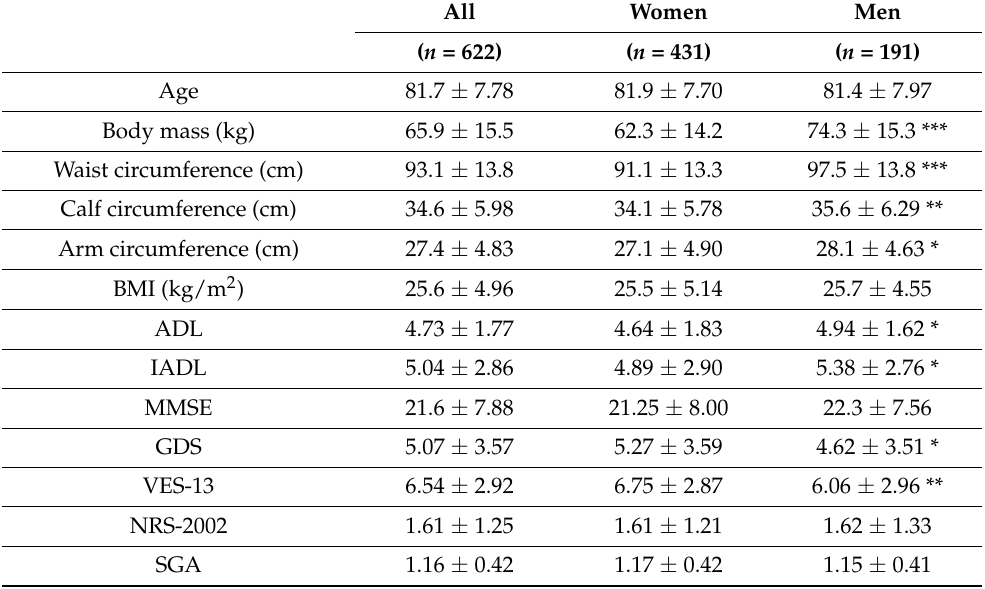
Table 1. Characteristics of the patients—summary statistics for age, anthropometric measurements, ADL, IADL, MMSE, GDS, VES-13, NRS-2002 and SGA. All Women